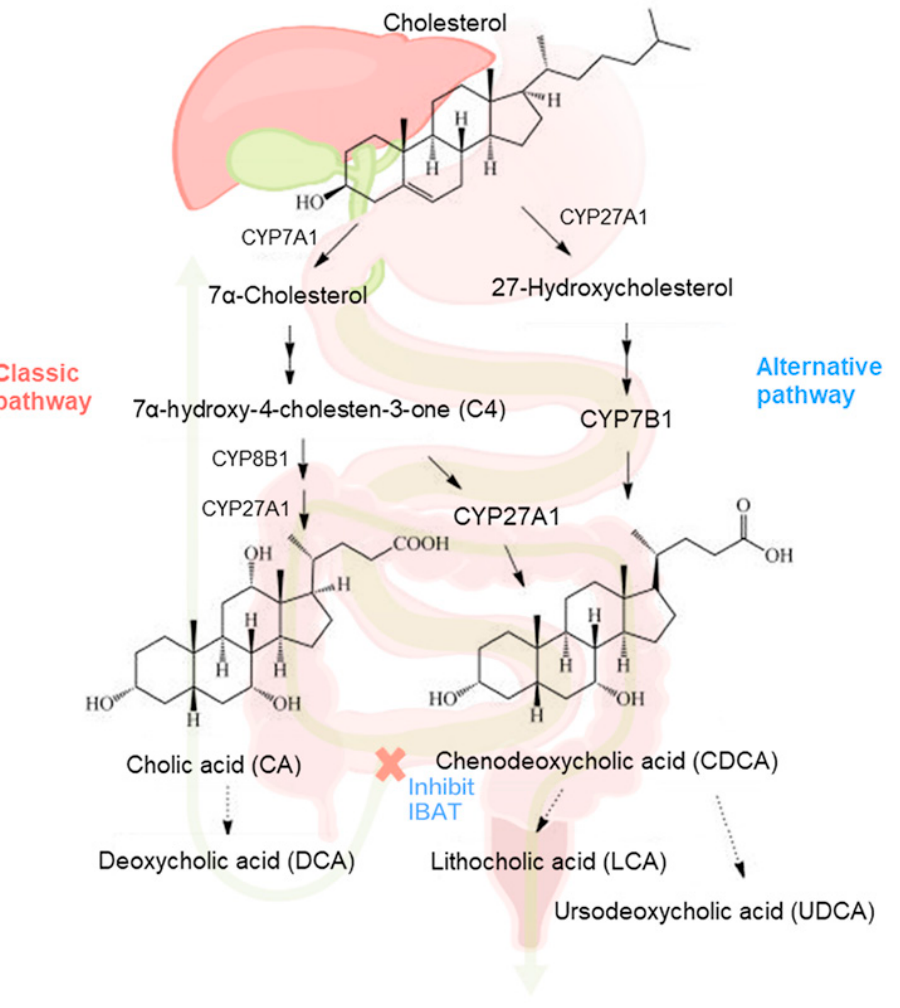
Figure 6. Illustration of BA metabolism in liver and intestine under MRX treatment .